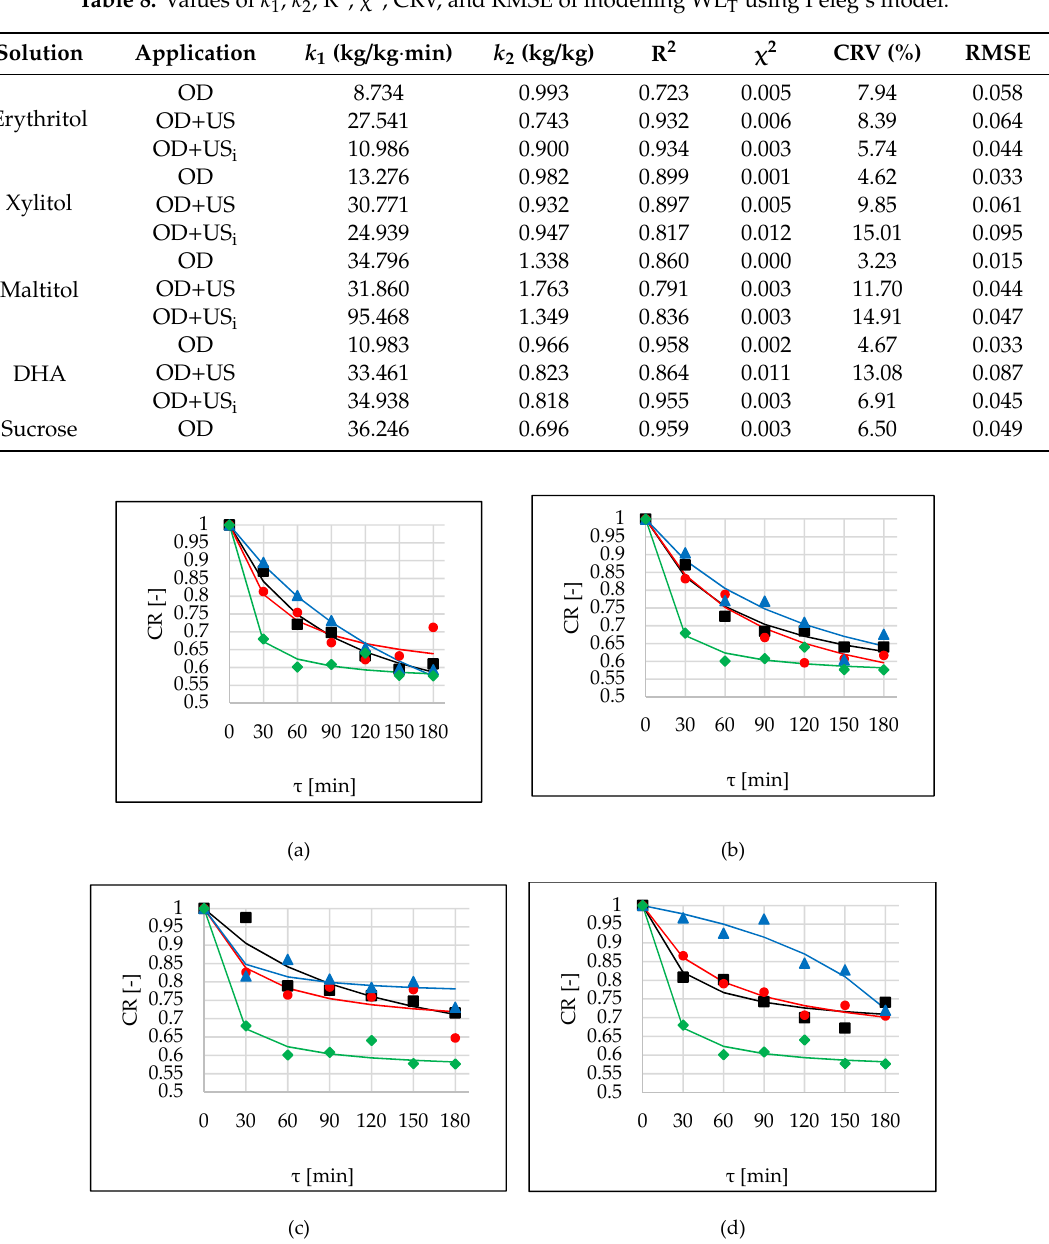
Table 8. Values of k 1 , k 2 , R 2 , χ 2 , CRV, and RMSE of modelling WL T using Peleg’s model.